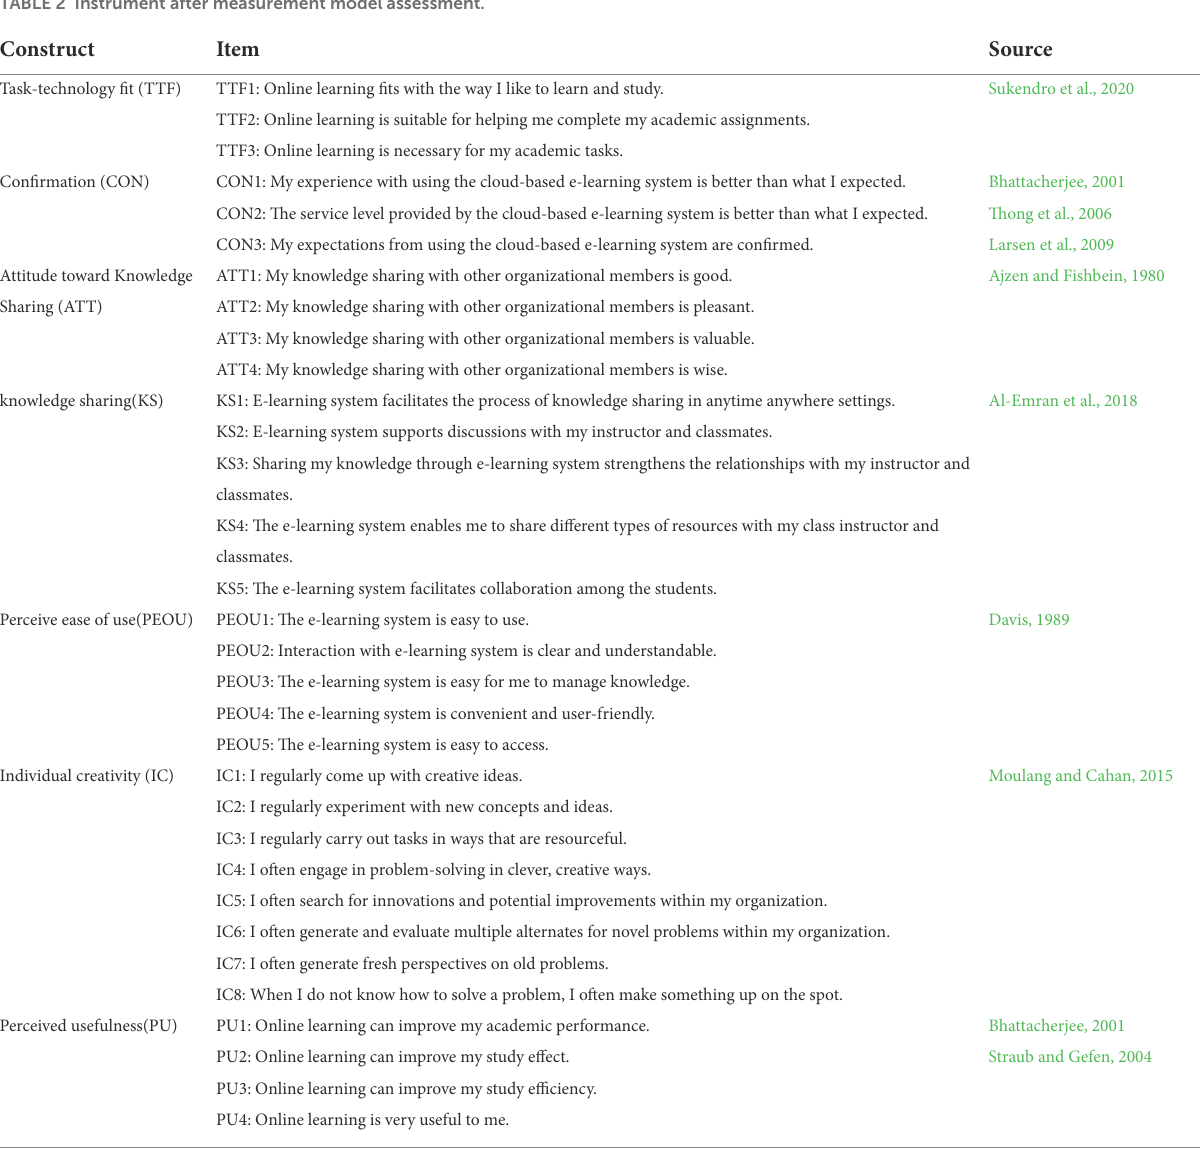
TABLE 2 Instrument after measurement model assessment. Construct Item Task-technology fit